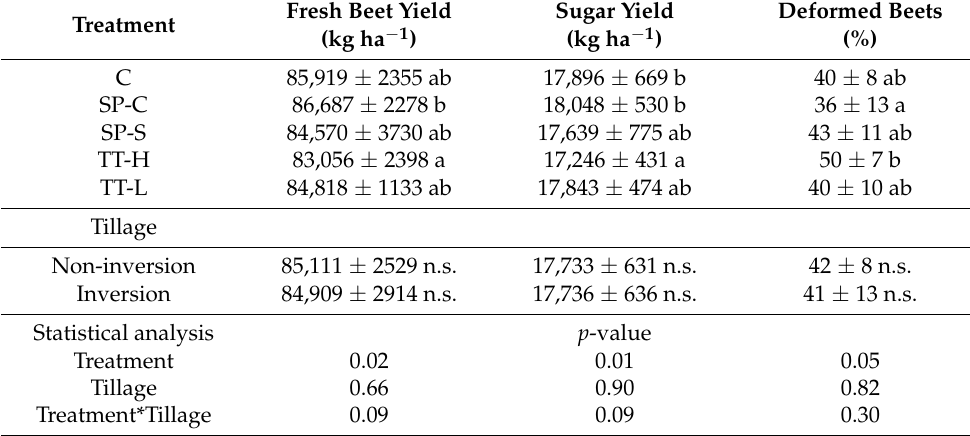
Table 6. Average fresh beet yield (kg ha − 1 ), sugar yield (kg ha − 1 ) and proportion of (seriously) deformed sugar beet roots (%-Classes 3 and 4) ± standard deviation ( n = 5) for the untreated control and the four experimental treatments and for the two tillage methods (inversion or ploughed and non-inversion) applied in this experiment. Different letters indicate significant differences ( p <